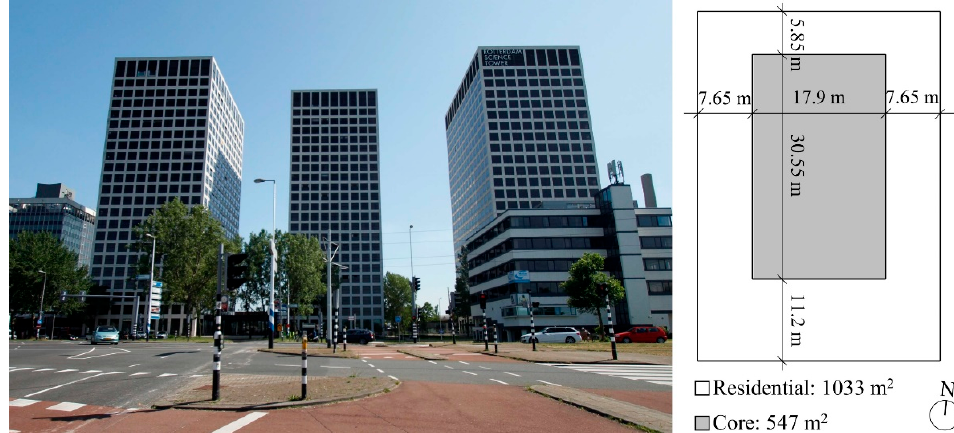
Figure 2. Europoint complex in Rotterdam, the Netherlands.